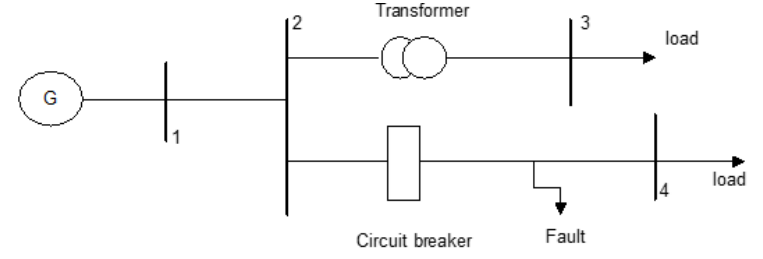
Figure 2. Test System.